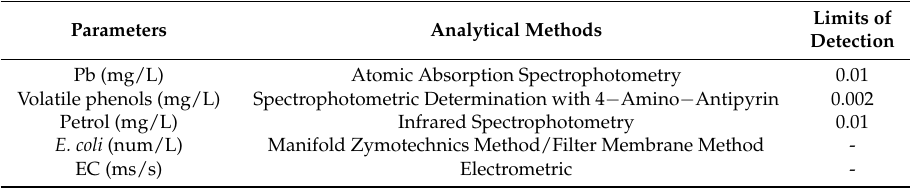
Table A2. Statistical description of discharge (2000 and 2002–2010, Liaozhong Gauging Station) that coincides with each type of flow period.